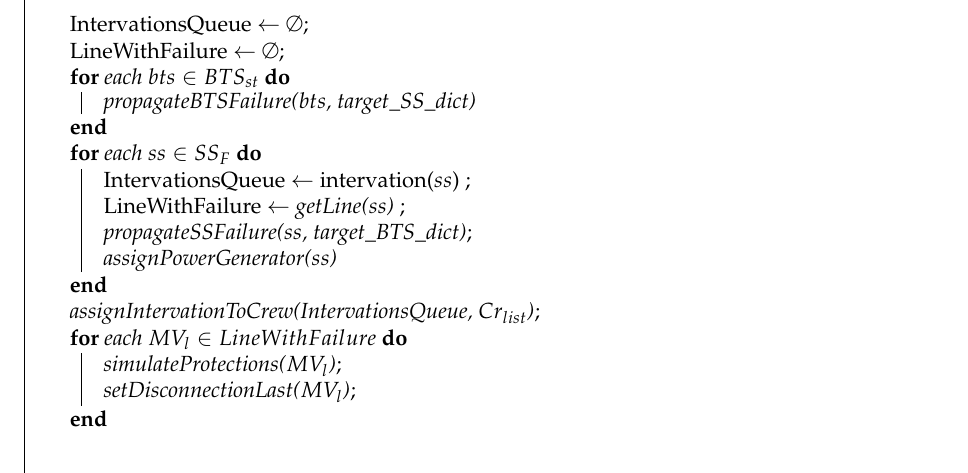
Figure A2. The restoration procedure algorithm